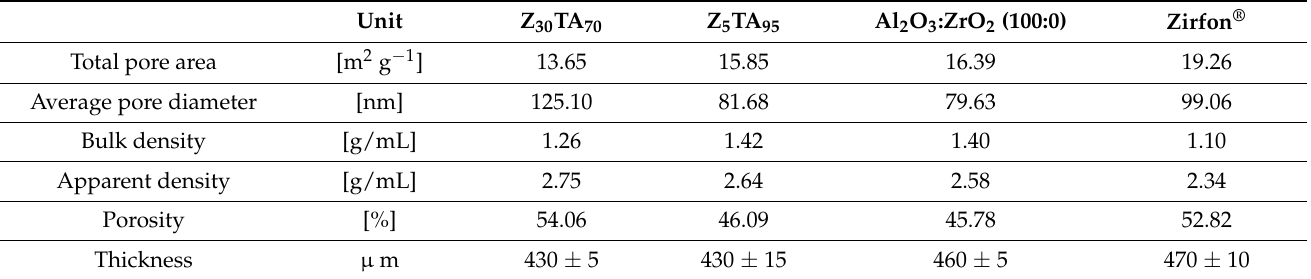
Figure 3. ( a ) Mercury incremental intrusion volume curves of Zirfon ® and the prepared separator membranes. ( b ) Area resistance of Zirfon ® and the prepared separator membranes. ( c ) Permeability of Zirfon ® and the prepared separator membranes. Table 2. The physical properties of Zirfon ® and the prepared separator membranes.